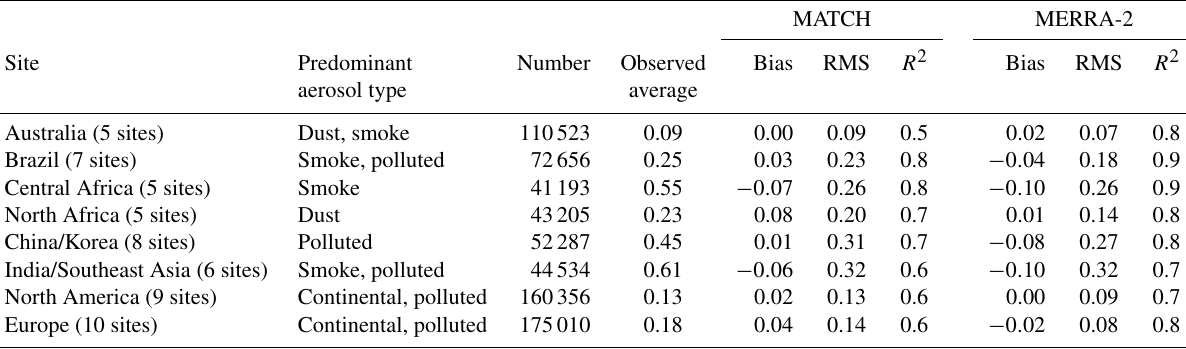
Table 4. Hourly AERONET station statistics for MATCH and MERRA-2 for continental groups under all-sky conditions ∗